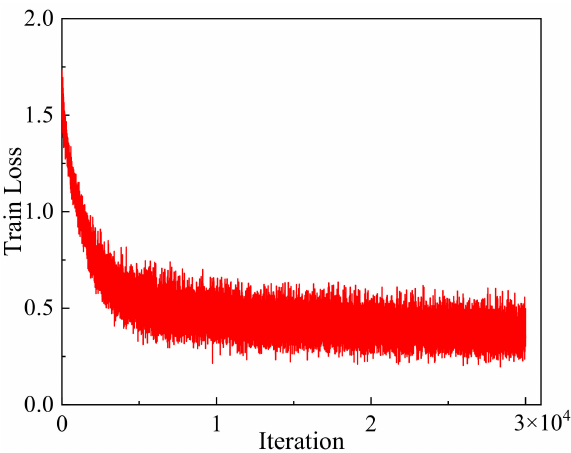
Figure 11. The training curves of three-storey